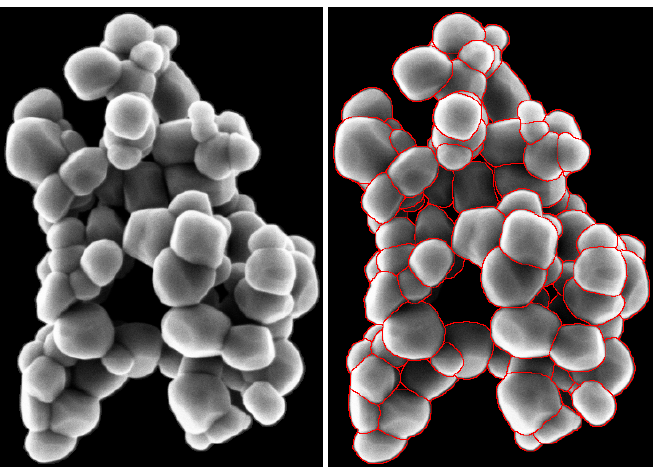
Figure 3. Extracted agglomerate of TiO 2 particles ( left figure ) and its segmented version ( right figure ).